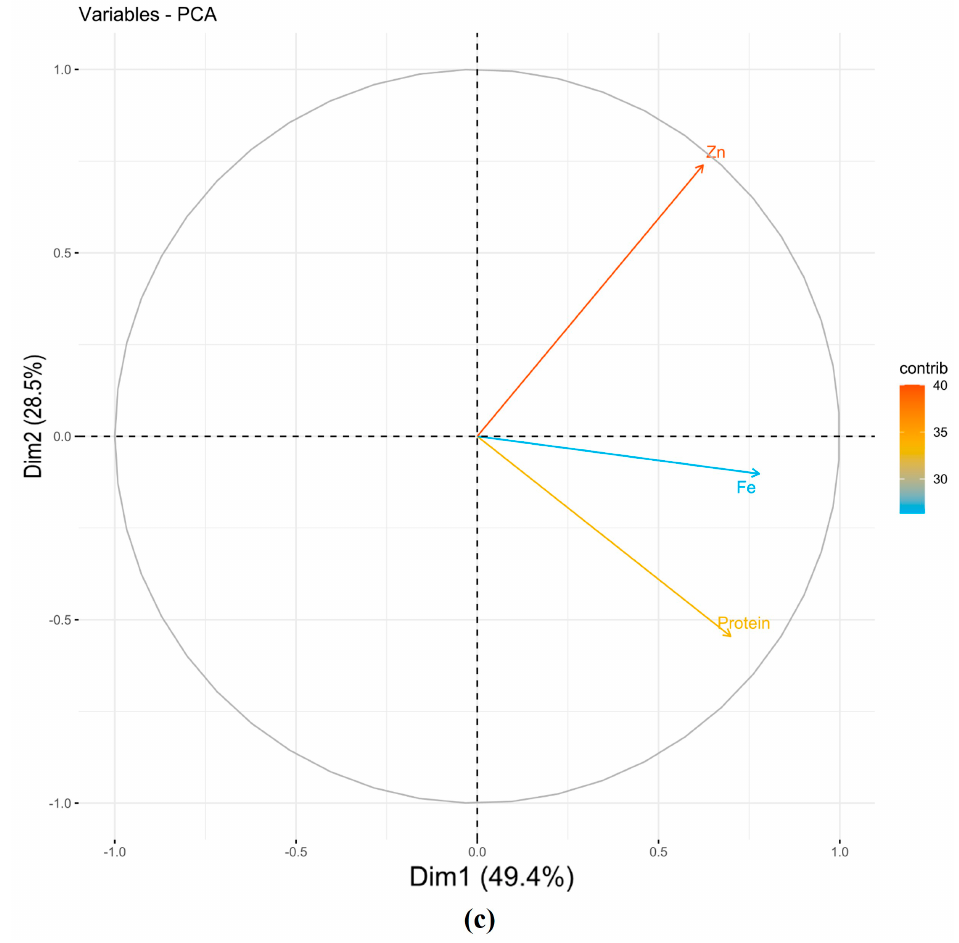
Figure 1. Estimated PCs for grain nutrients (protein, Fe, and Zn) under NSI, NSII, and pooled sea- sons ( a , b , c ), respectively. Fe, grain iron content; Zn, grain zinc content; NS, normal